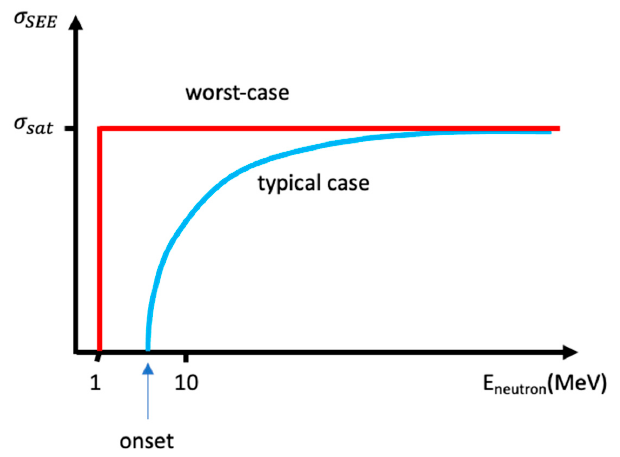
Figure 1. Illustration of cross section versus neutron energy in a typical case (where the onset is between 1 and 10 MeV) and the worst-case scenario yielding the highest SER. Table 1. Contribution of four main energy ranges to the SER in the framework of the worst-case analysis, i.e., with constant SEE cross sections for neutrons above 1 MeV. Calculations were made using the flux of the IEC standard divided by 300 to obtain the contributions at ground level. Energy Range SER (FIT/Mcell) Contribution to Total SER